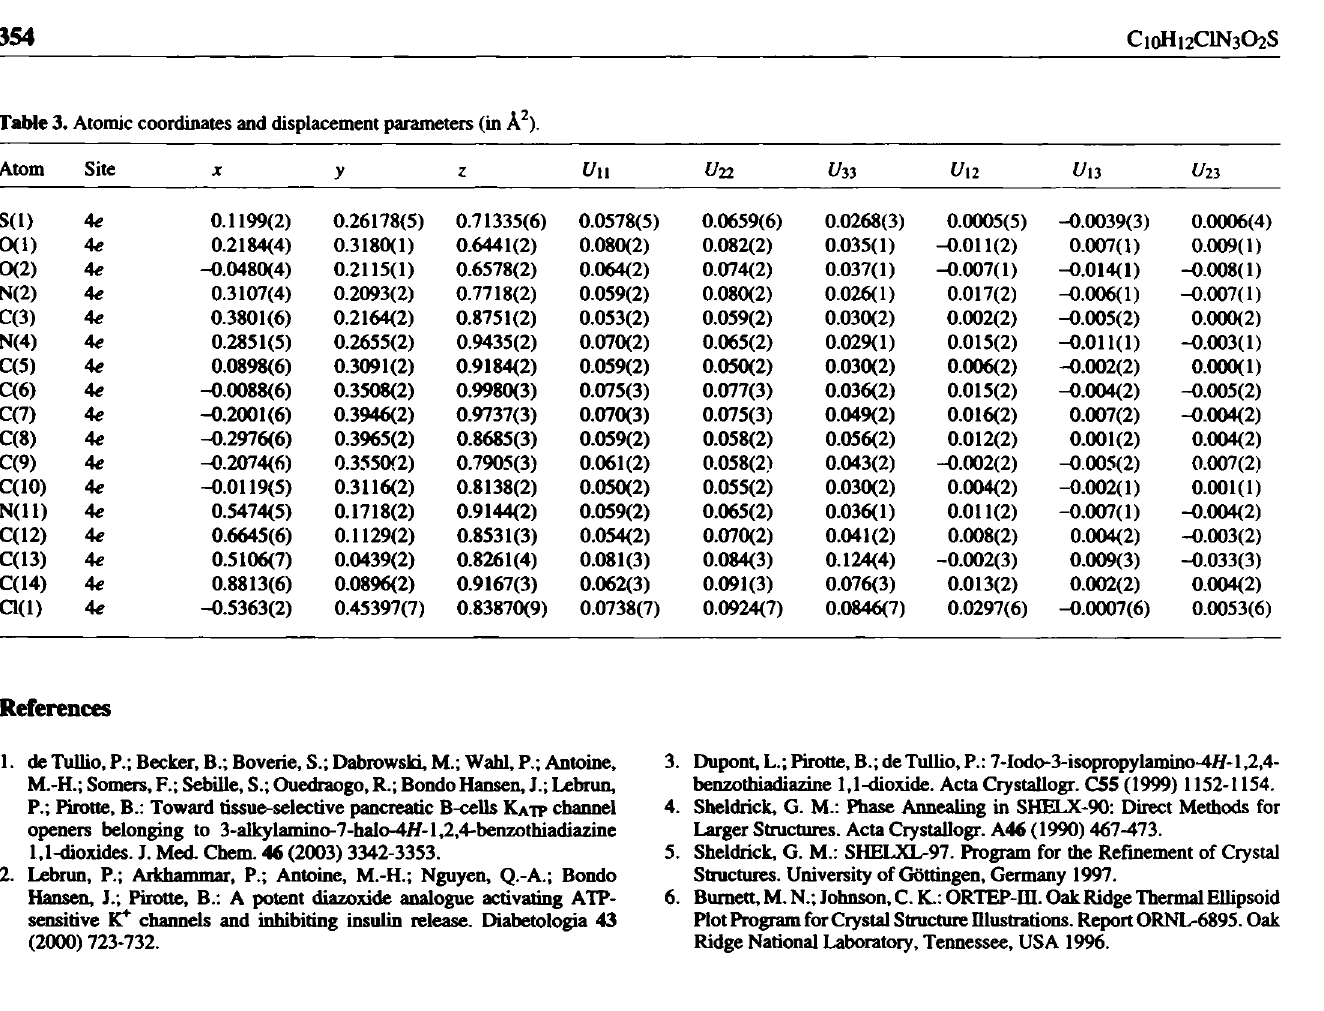
Table 3. Atomic coordinates and displacement parameters (in A 2